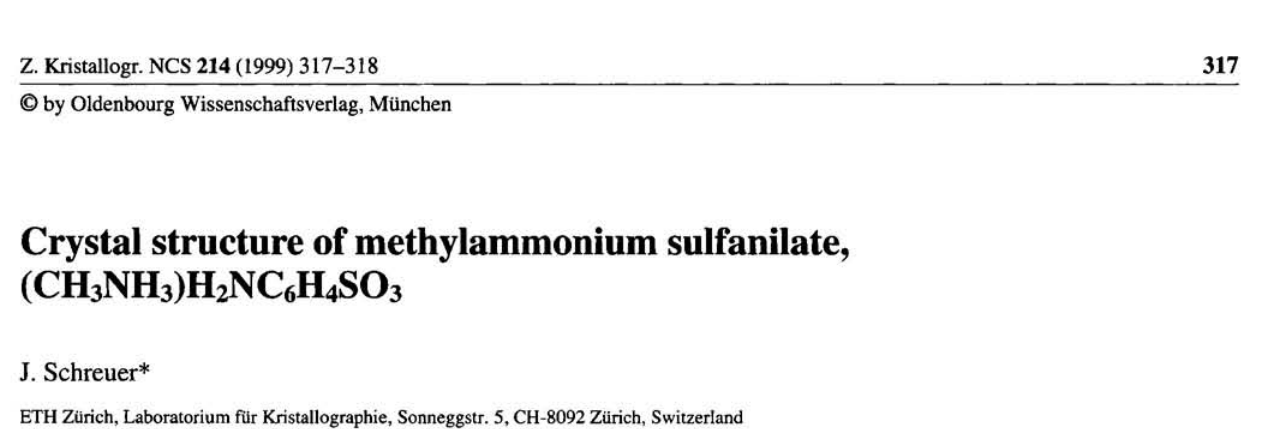
Table 1. Data collection and handling.